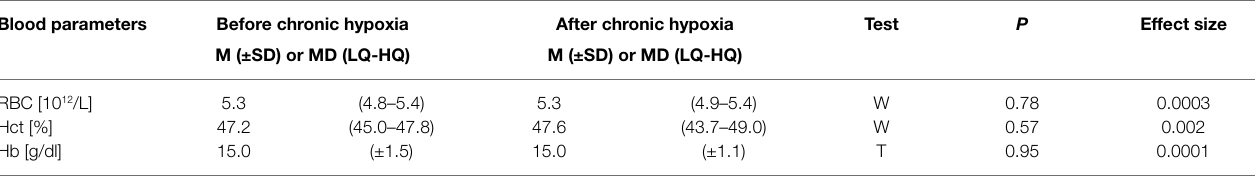
TABLE 4 | Blood parameters measured before and after 1 month of sojourn at a very high altitude (mean altitude of 4,900 ± 60 m). Blood